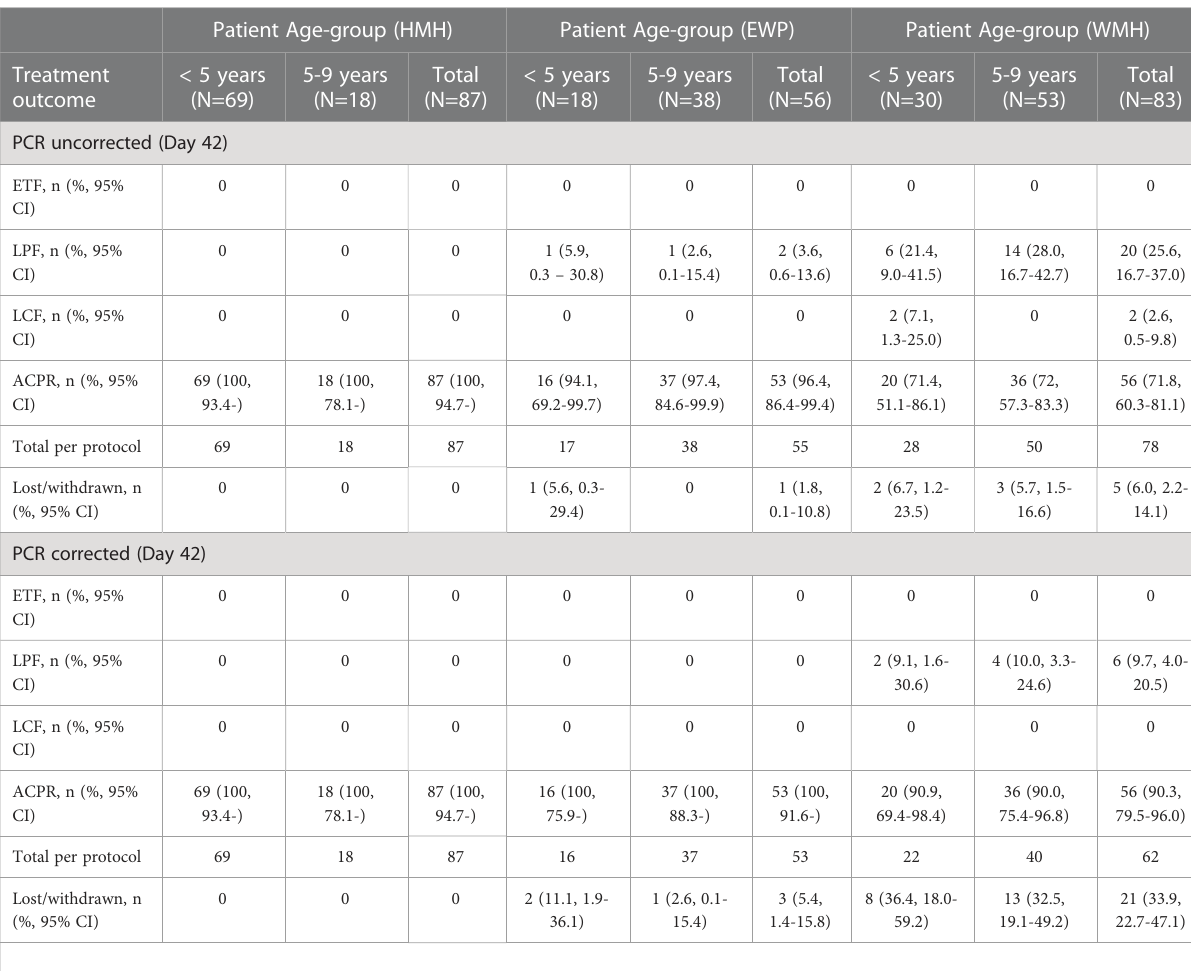
TABLE 3 Per protocol DHAP treatment outcomes. Patient Age-group (HMH) Patient Age-group (EWP) Patient Age-group (WMH) Treatment